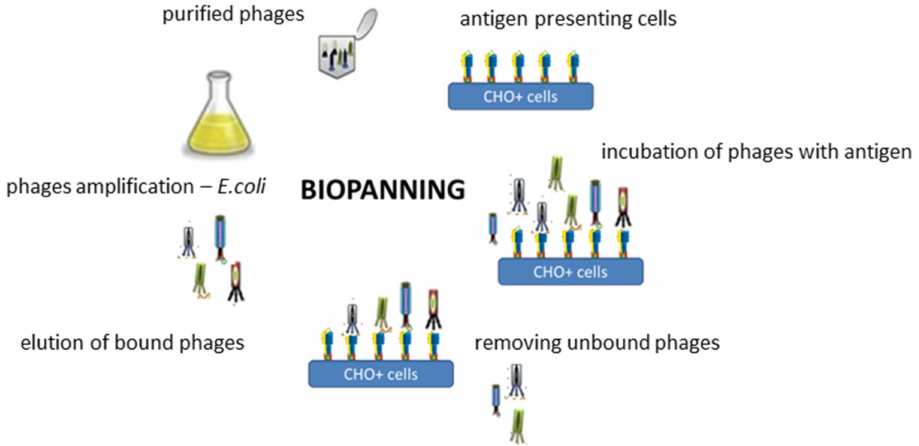
Figure 7. Phage display technique—biopanning process. For the isolation of phages specifically recognizing the D 2 -5-HT 1 A heteromer, the immune-selection rounds were performed. Purified phages were incubated with CHO+ line cells (CHO-K1 stable line) overexpressing both types of desired receptors. In the next step unbounded phages were removed in the process of intensive rinsing. Then the selected phages which point to affinity to D 2 -5-HT 1A heteromer were eluted, amplified, purified and used in the next round of the positive selection. Detailed information